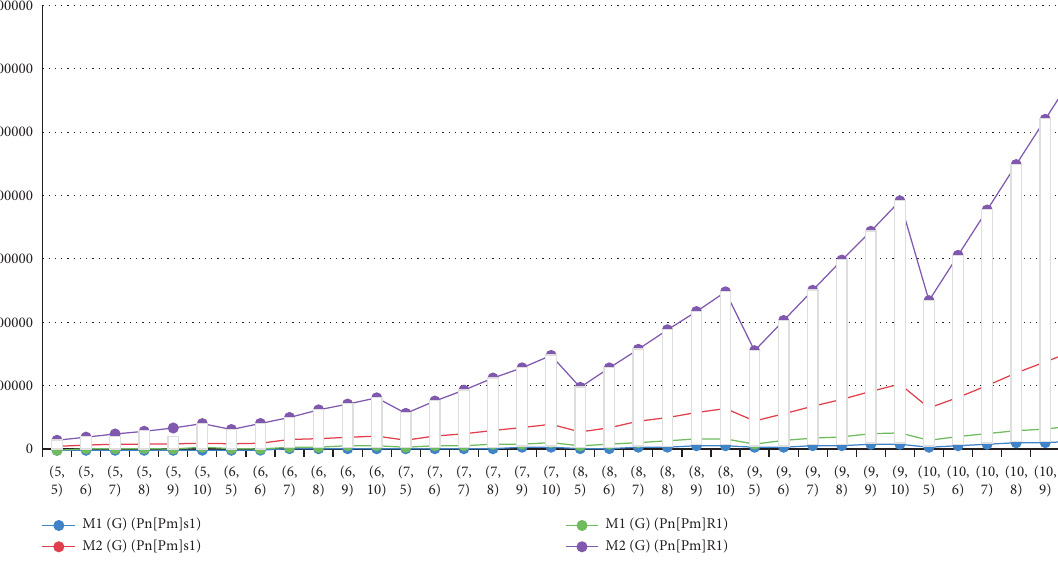
Figure 5: Numerical comparison of Zagreb indices of generalized subdivision and semitotal point operations with lexicographic product of the networks for k �